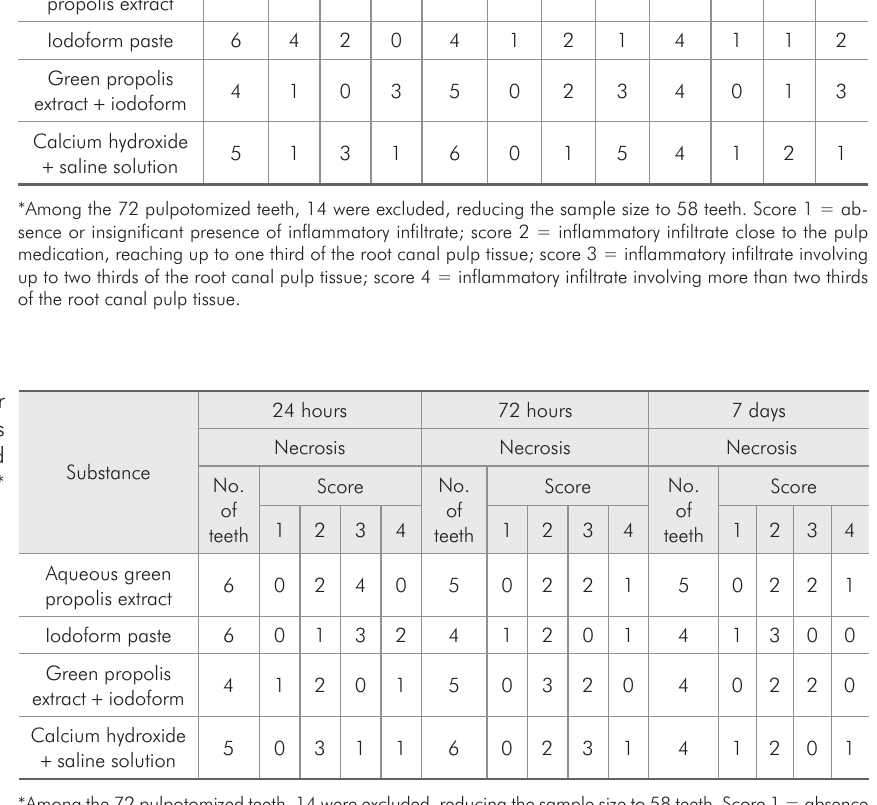
Table 1 - Distribution of number of teeth according to substances tested, evaluation time and intensity of inflammatory